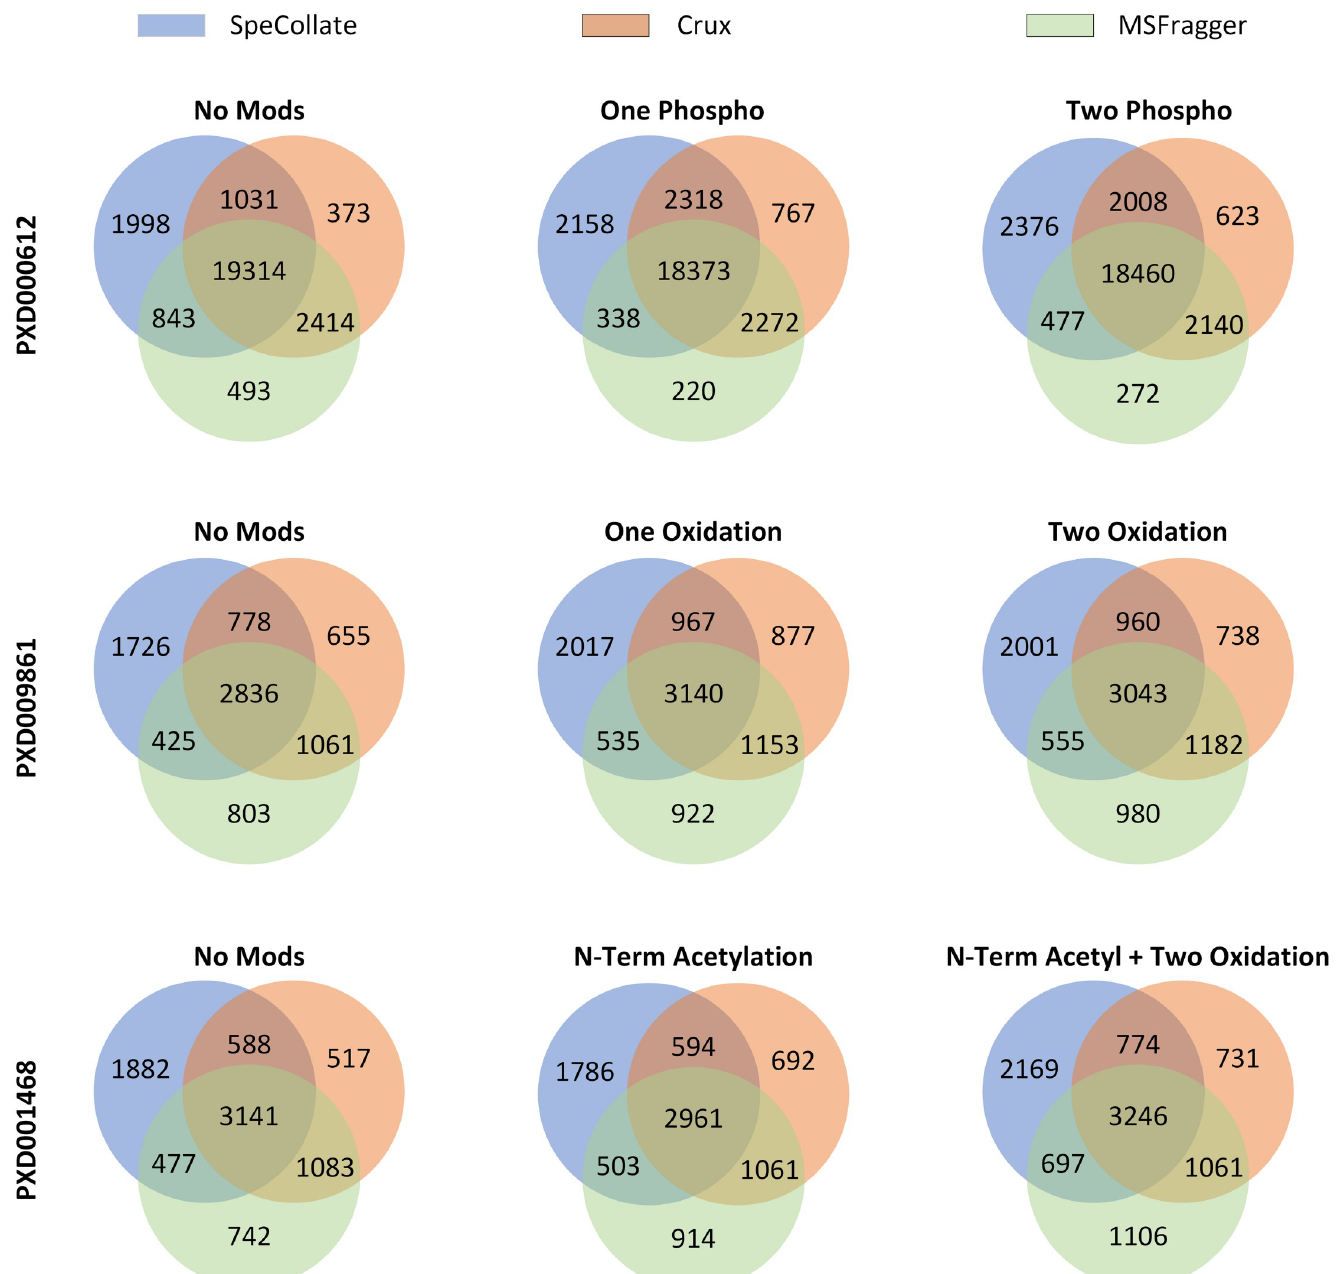
Fig 11. Venn diagrams showing the overlap of peptides among SpeCollate, Crux, and MSFragger. As can be seen, most of the peptides are common among the three tools while SpeCollate does identify most unique peptides compared to Crux and MSFragger. See S4 File for list of peptides identified in each